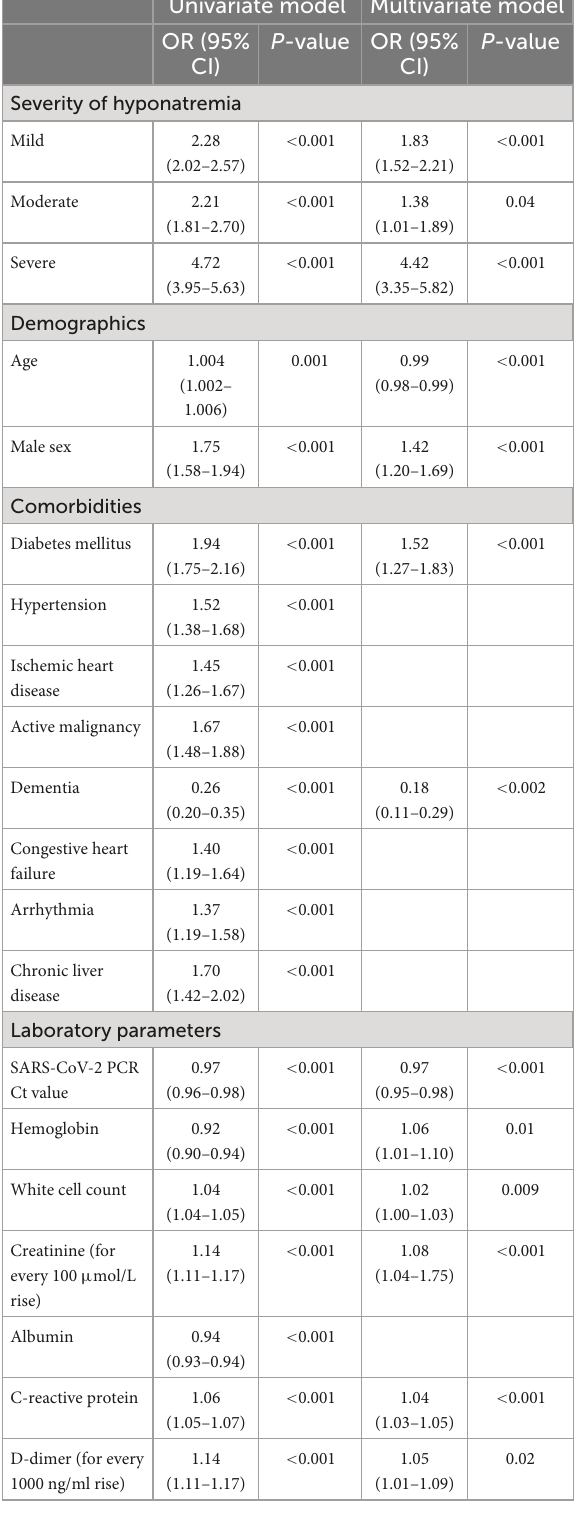
TABLE 3 Predictors of intensive care unit admission in patients with COVID-19. Univariate model Multivariate model